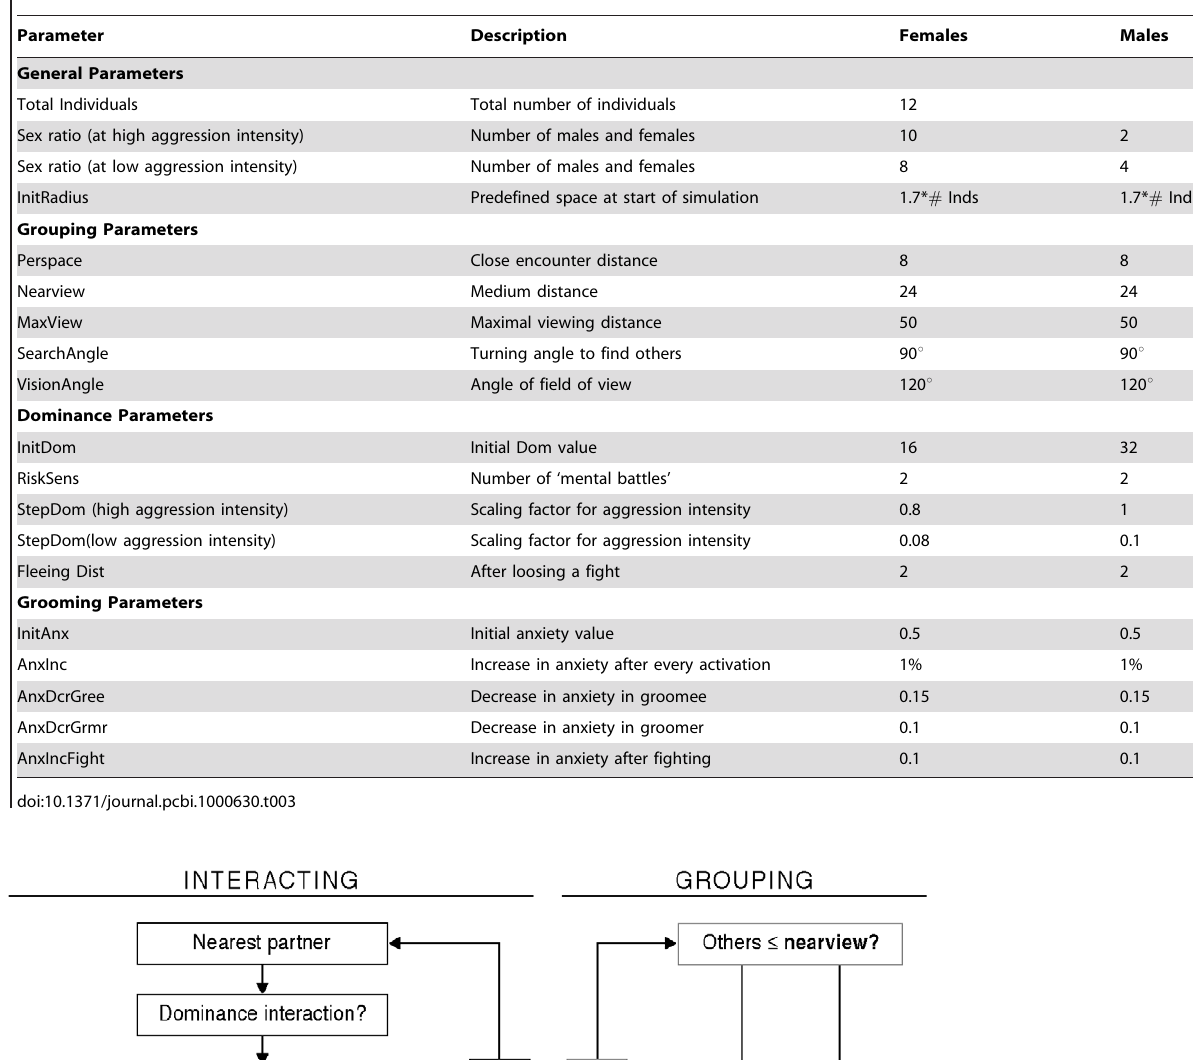
Table 3. Default parameter values in ‘GrooFiWorld’.